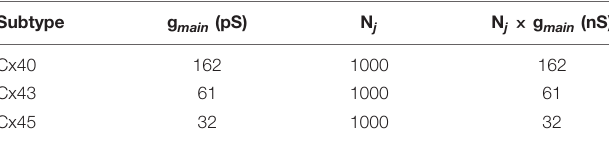
TABLE 2 | Differences in unitary conductances between various gap junction